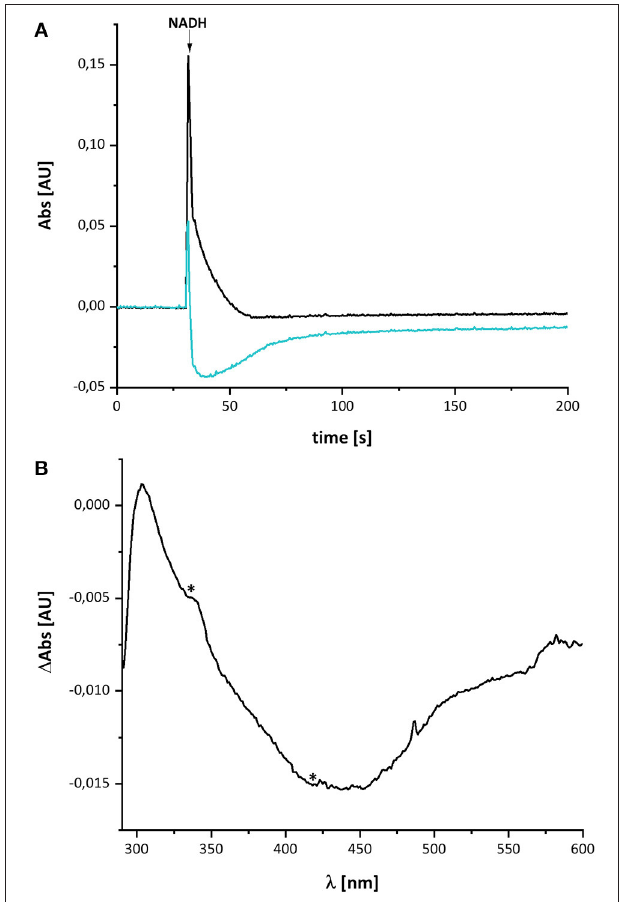
FIGURE 3 | UV-vis spectra of decyl-Q. (A) Absorbance spectra of 60 µ M decyl-Q in water:ethanol (20:80, v:v; black), after addition of NaBH 4 and adjustment of pH to 7.0 resulting in the formation of decyl-QH 2 (red) and after addition of 0.2M NaOH (pH ∼ 13) resulting in the formation of decyl-QH − anion (blue). (B) Shows the (reduced-minus-oxidized) difference spectrum of (quinol-minus-quinone) in black and (quinol anion-minus-quinone) in